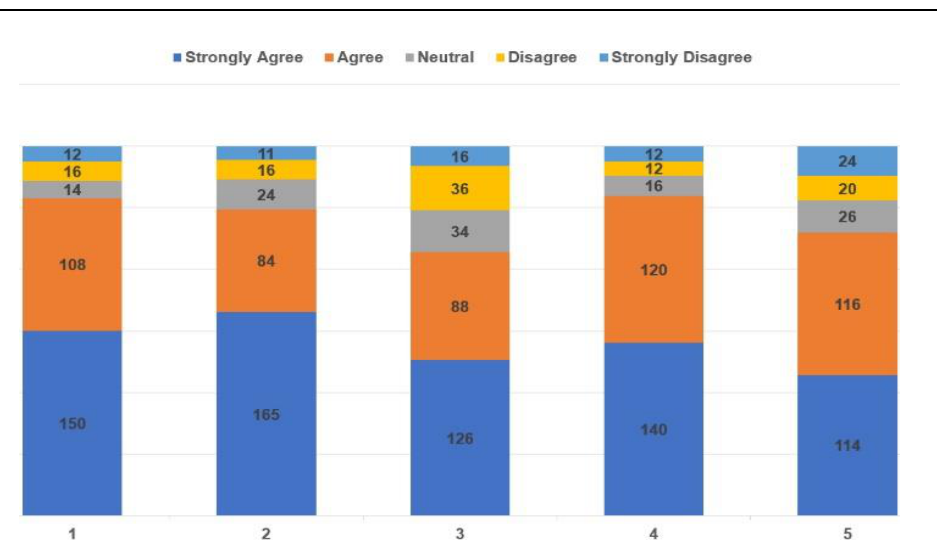
Figure 9. This cumulative columnar bar graph displays the response of survey results of 300 expert users for the success of the MoLaBSS. The X-Axis shows the survey questions (1 to 5). The Y-Axis displays the number of users who responded on the Likert, from strongly agree to strongly